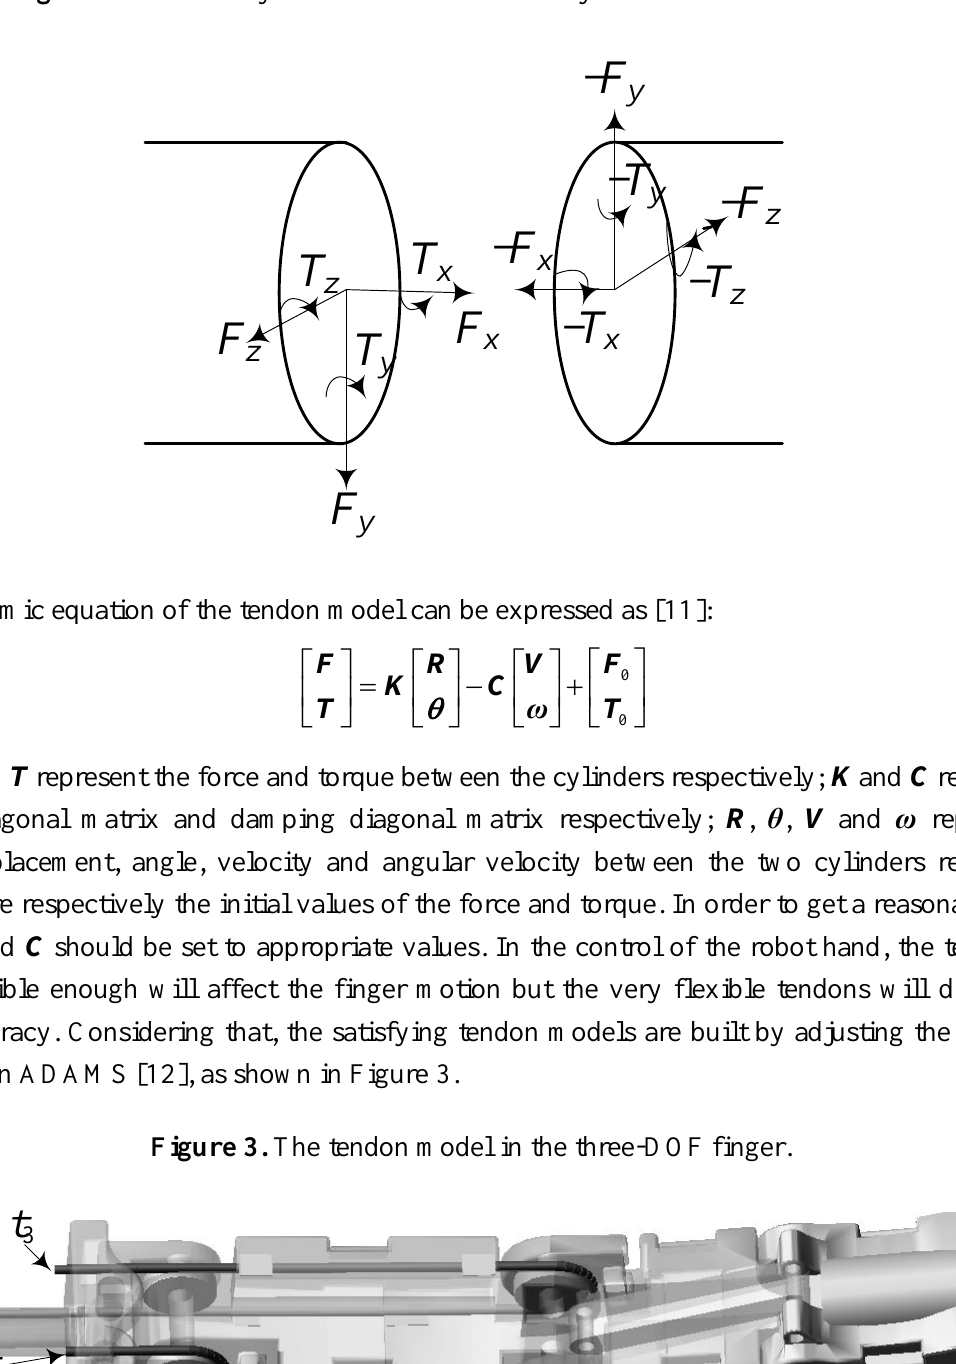
Figure 2. Force analysis between a two small cylinders of the tendon model.